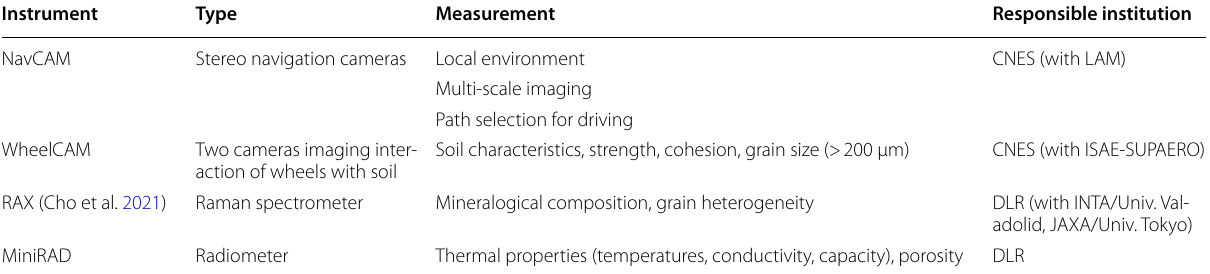
Table 5 Instruments on MMX